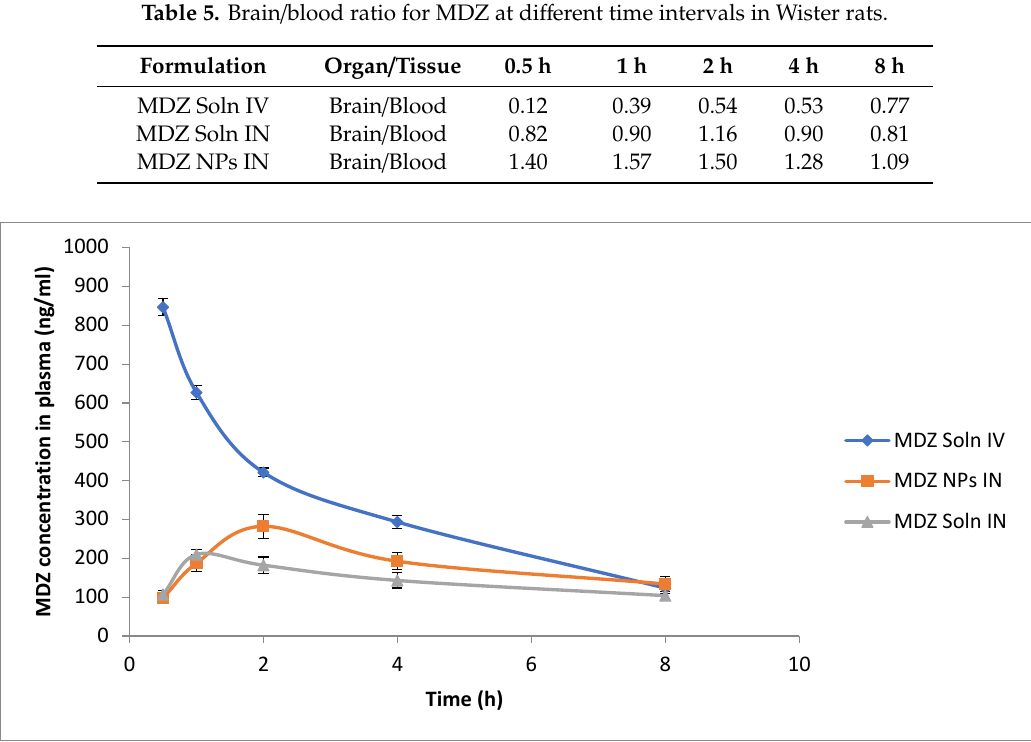
Figure 5. Graph of MDZ concentration in plasma at different time intervals following MDZ solution intravenous (IV), MDZ solution intranasal (IN), and MDZ CS NPs IN administration ( n = 3, mean ± S.D.)